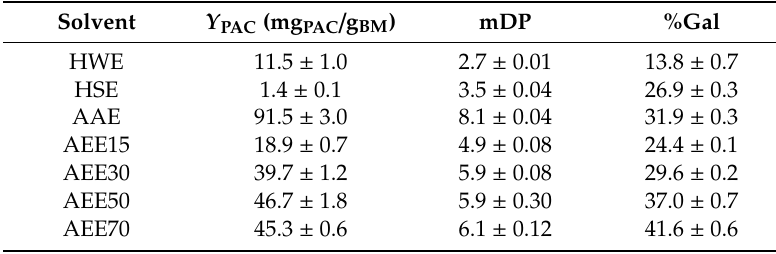
Table A3. Experimental values of Y PAC , mDP and %Gal obtained with conventional